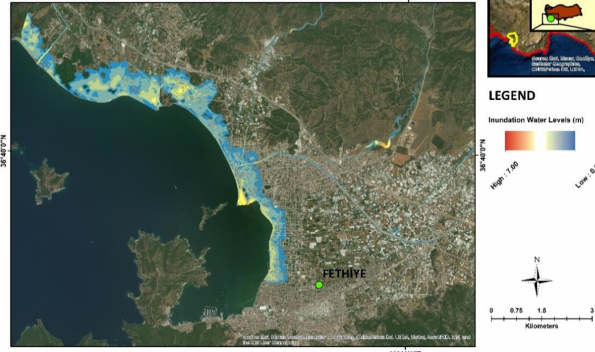
Figure 11. Inundation levels resulting from an earthquake-triggered tsunami hazard (sources: Esri, Maxar, GeoEye, Earthstar Geograph- ics, CNES/Airbus DS, USDA, USGS, AeroGRID, IGN, and the GIS User Community).